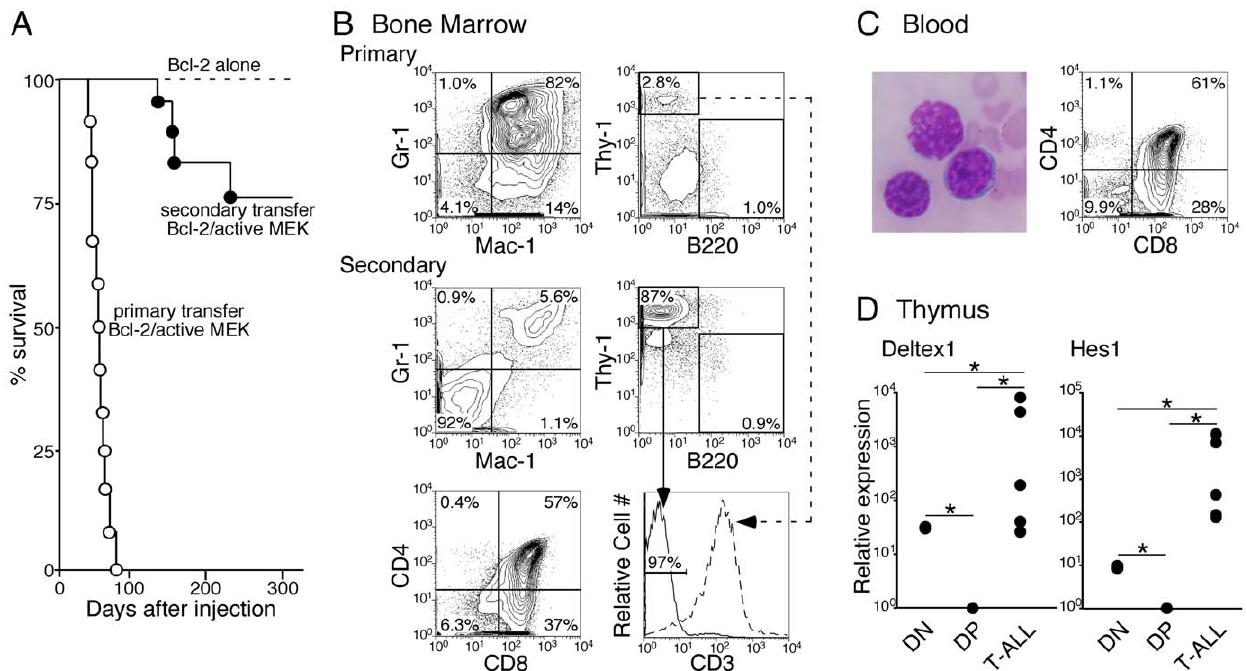
Figure 4. Transplantation of Bcl-2/active MEK + -induced MPNs results in greater frequency of T-ALL. (A) A Kaplan-Meier curve illustrating the survival time of primary transplanted mice reconstituted with hematopoietic stem cells (HSCs) harvested from a Bcl-2 + transgenic mouse infected with control (dotted line, n=8) or active MEK (open circles, n=17) retrovirus and Bcl-2/active MEK + secondary transplanted mice (closed circles, n=18). Approximately 10,000 retrovirally infected (GFP + ) HSCs were injected into sublethally irradiated RAG-2 2 / 2 recipients for primary transplants. Survival of primary transplanted mice was monitored for at least 120 days post-injection. Cells from the bone marrow or spleen of mice with Bcl-2/ active MEK + -induced MDS/MPN were injected into sublethally irradiated naı¨ve RAG-2 2 / 2 recipient mice. Survival of secondary transplanted mice was monitored for at least 365 days post-injection. (B) At the terminal stage, bone marrow was harvested from moribund primary transplanted (top panel) and moribund secondary transplanted (bottom panel) mice. Secondary transplanted mice were generated by harvesting bone marrow or spleen cells from moribund active MEK or Bcl-2/active MEK + mice and transplanted into naı¨ve recipient mice. Cells were stained with various lineage antibodies and subjected to FACS analysis. CD3 expression on Thy-1 + T cells was further analyzed in primary (dotted arrow) and secondary (solid arrow) mice. CD4 and CD8 expression in bone marrow was also examined in secondary transplanted mice. All plots are pre-gated on PI 2 GFP + cells. Data is from one representative mouse out of five mice. (C) Histology of peripheral blood from secondary transplanted mice. Peripheral blood smears were stained with Wright-Giemsa stain (top panel). Zoom=400 6 . Peripheral blood was also subjected to FACS analysis to examine CD4 and CD8 expression. Cells were pre-gated on PI 2 GFP + cells. One representative smear and FACS plot is shown for five analyzed mice. (D) Quantitative RT-PCR analysis of deltex- 1 (left panel) and hes-1 (right panel) in CD4 2 CD8 2 DN thymocytes (n=3), CD4 + CD8 + DP thymocytes (n=3), and GFP + bone marrow cells from mice with T-ALL (n=5). Relative expression level for each gene is normalized to b -actin expression level and plotted on a bar graph. The mean normalized expression level for each group was calculated and used to determine fold induction above DP cells. Expression level of the gene was arbitrarily set at 1 for DP cells. Fold induction over DP is expressed for each corresponding group. Standard deviation was calculated for each sample assayed in triplicate. *, P , 0.05 (statistical significance) by Student t test.